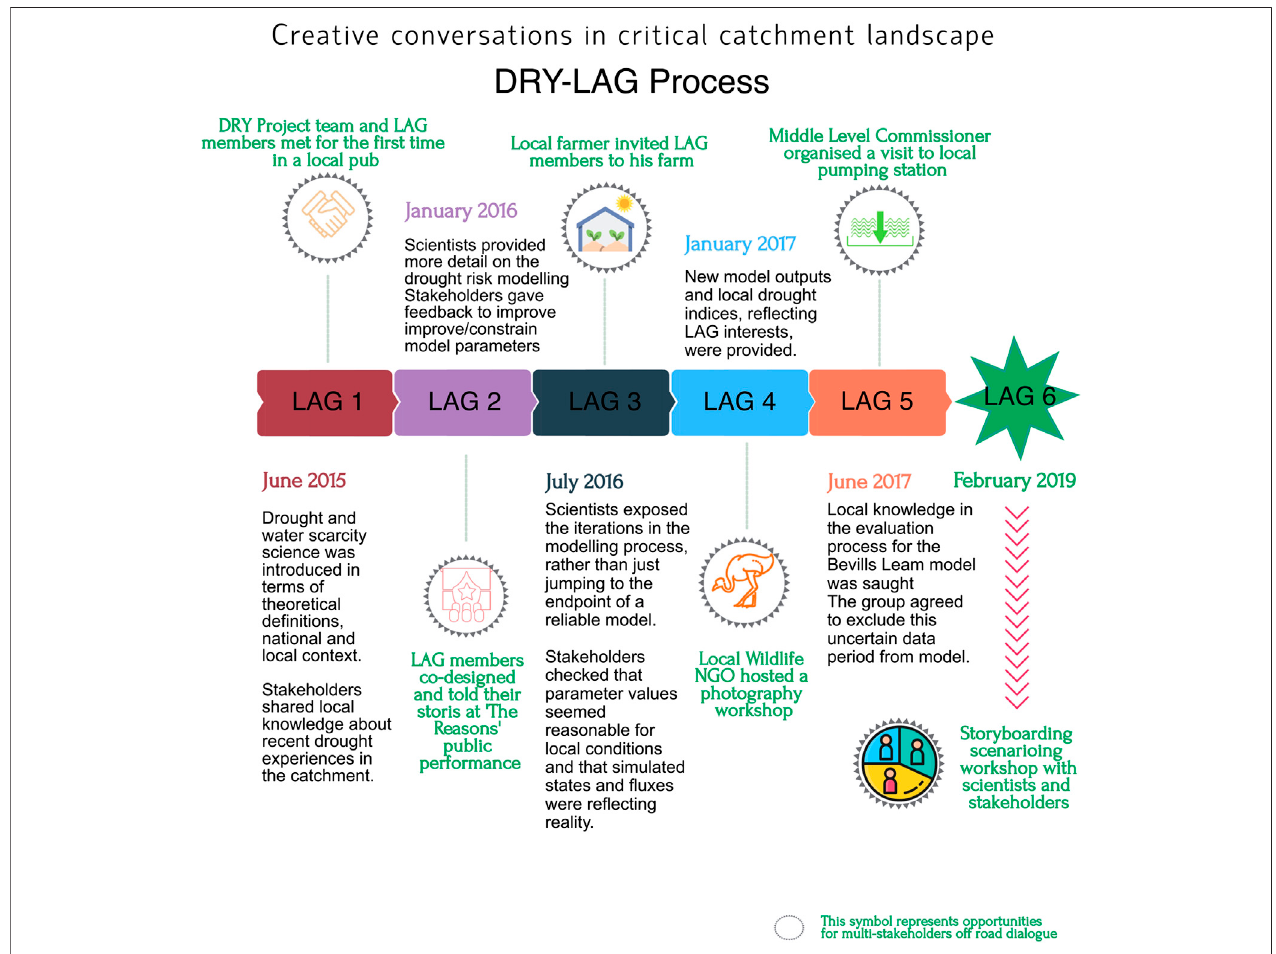
FIGURE 1 | Timeline for stakeholder engagement in the Bevills Leam catchment, indicating past reconstruction and future facing scenario-ing activities.